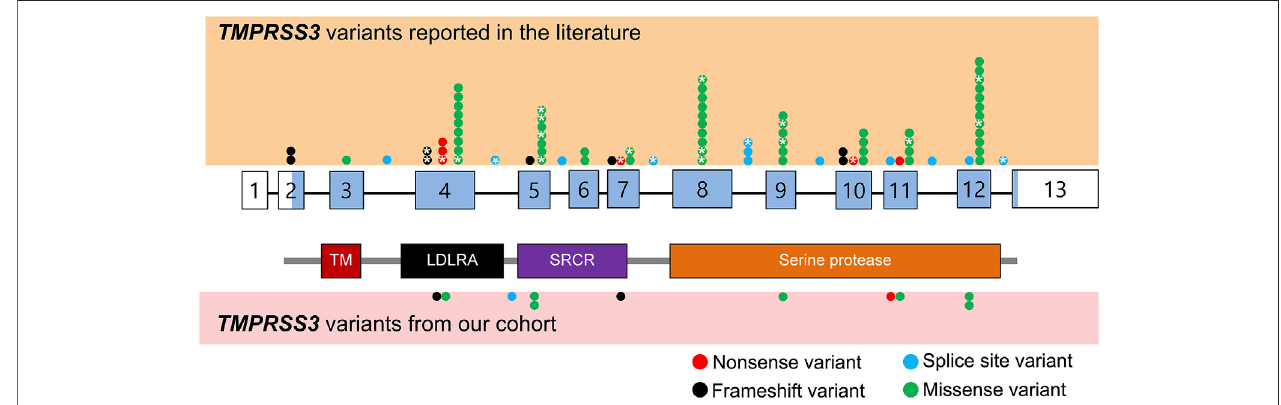
FIGURE1| Schematicrepresentation of TMPRSS3 variants identi fi edfromliteraturereviewaswellasourcohort.Benignvariantsarenotdisplayed.Theexonsare numbered with coding sequence shaded blue and untranslated regions unshaded. *: variants with reported cochlear implant outcomes. TM, transmembrane domain; LDLRA, LDL receptor-like domain; SRCR, scavenger receptor cysteine-rich